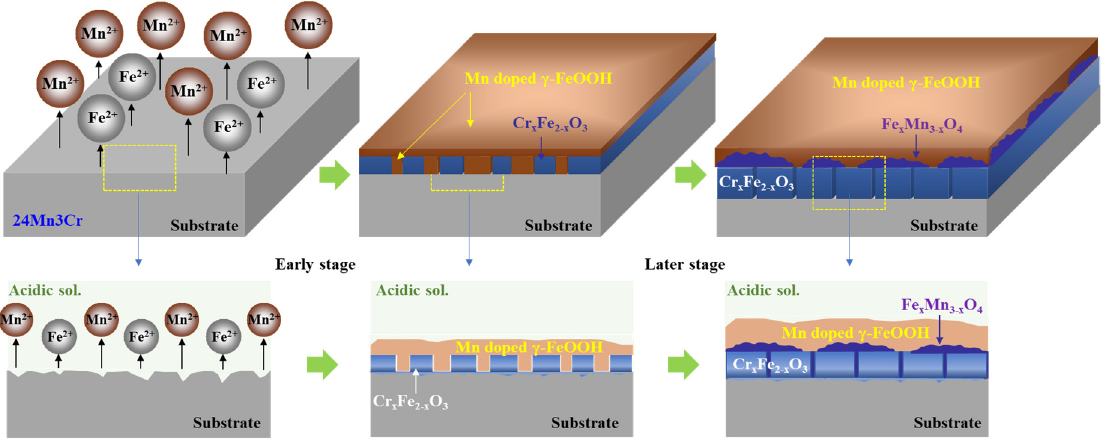
Figure 8. Schematic diagram of the long-term corrosion mechanism of 24Mn3Cr steel under acidic environments.